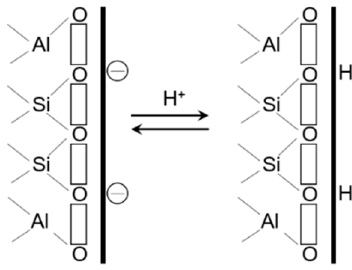
Figure 2. Reaction on the basal surface of a clay mineral. Reprinted with permission from reference [33].